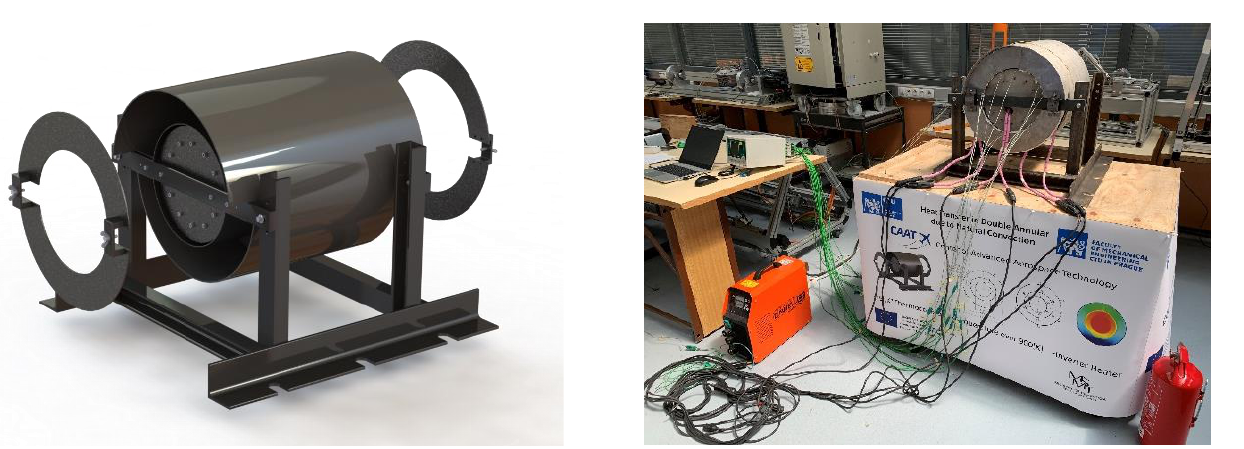
Fig. 16. Experimental measuring on the stand .